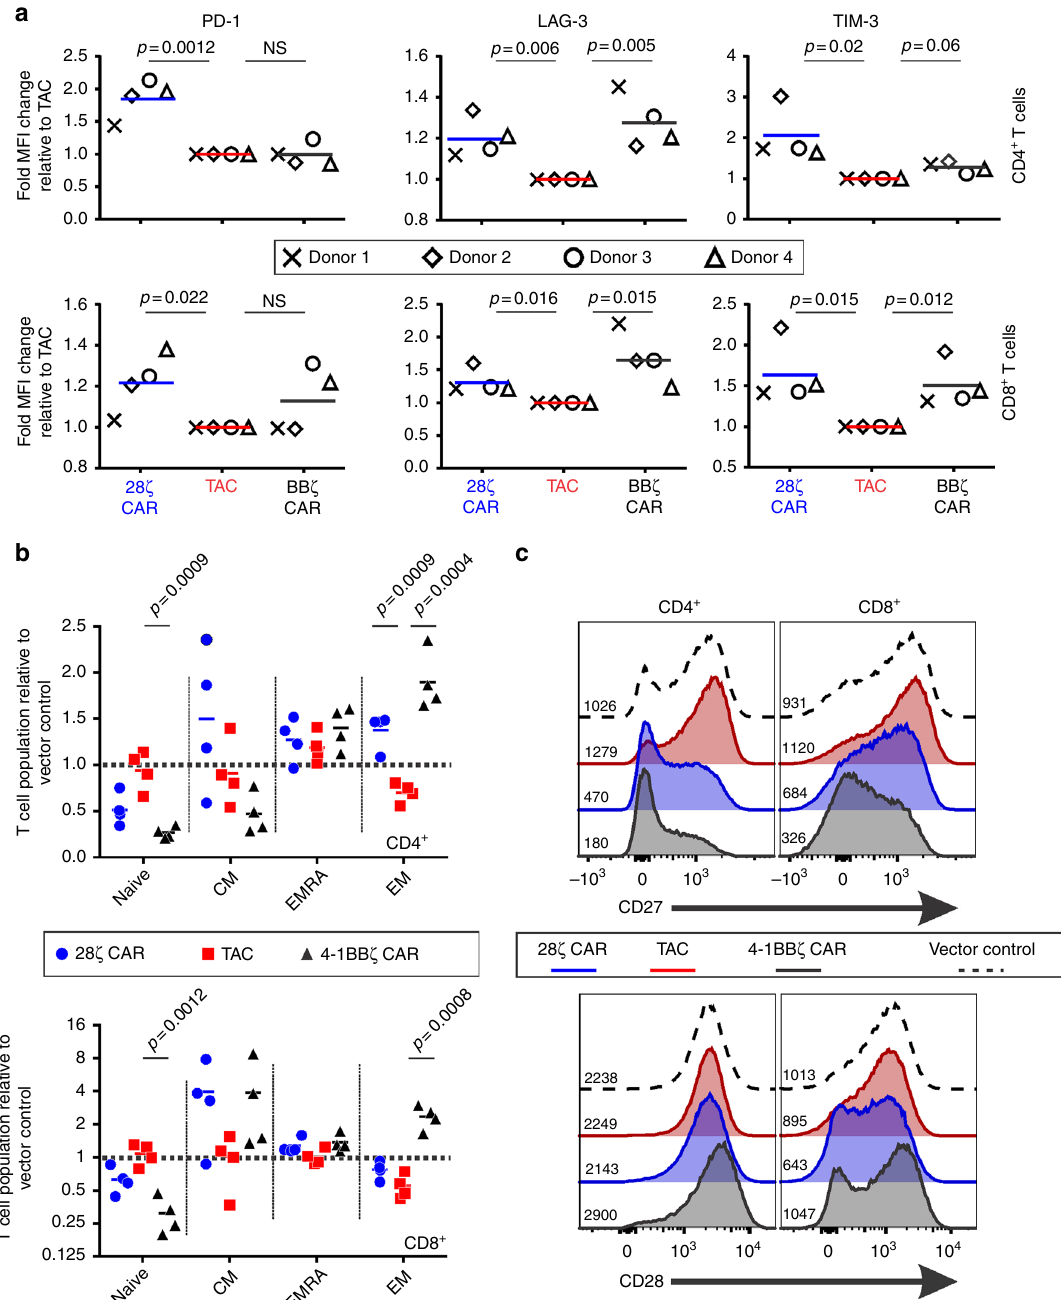
Fig. 3 Relative expression of checkpoint receptors and memory T cell subsets in CAR- and TAC-engineered T cells. T cells were transduced with HER2- TAC, or a second-generation anti-HER2 CAR including the CD28 (28 ζ CAR) or 4-1BB (BB ζ CAR) costimulatory receptor domains, or a vector control (tNGFR). Engineered T cells are stained for surface marker expression and CD4 + NGFR + or CD8 + NGFR + populations are analyzed by fl ow cytometry for ( a ) expression of checkpoint receptors PD-1, LAG-3, and TIM-3. All data is normalized to TAC-engineered T cells, and lines represent the mean of four donors. Each donor is represented by a unique symbol to highlight donor-to-donor variations. Multiple t -test is used to determine signi fi cance. For the gating strategy see Supplementary Fig. 14. b Memory T cell subsets of TAC-, 28 ζ CAR-, and BB ζ CAR-T cells, relative to T cells engineered with a vector control (tNGFR). T cell subsets are de fi ned as naïve (CD45RA + , CCR7 + ), central memory (CM) (CD45RA − , CCR7 + ), effector memory (EM) (CD45RA − , CCR7 − ), and terminal effectors (EMRA) (CD45RA + , CCR7 − ). Lines represent the mean of four donors. Multiple t -test is used to determine signi fi cance. c CD27 and CD28 expression; representative histograms show data from one donor, median fl uorescence intensity is indicated. Data are from two independent experiments with four different donors. For both ( b ) and ( c ), the gating strategy is shown in Supplementary Fig. 15 NATURE COMMUNICATIONS| (2018) 9:3049 |DOI: